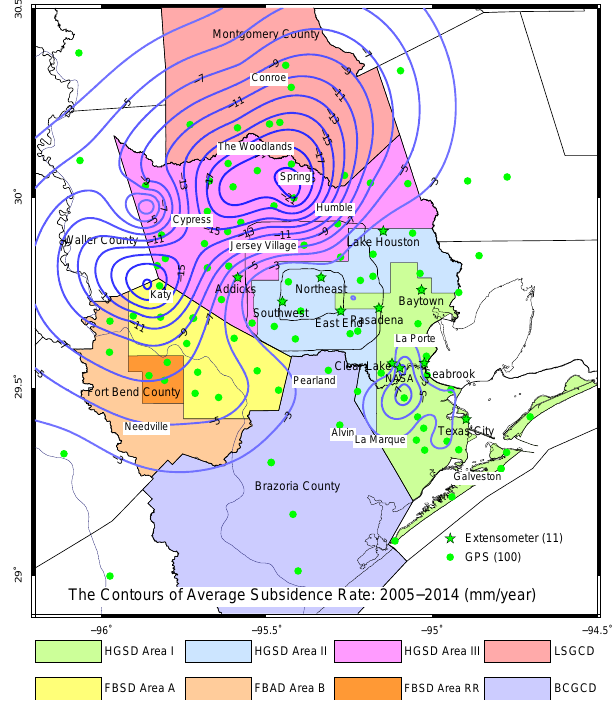
Figure 3. Average subsidence rate occurring from 2005 to 2014 in the Houston metropolitan area, Texas. The colored areas indi- cate the current groundwater conservation zones regulated by the Harris-Galveston Subsidence District (HGSD), the Fort Bend Sub- sidence District (FBSD), the Lone Star Groundwater Conservation District (LSGCD), and the Brazoria County Groundwater Conser- vation District